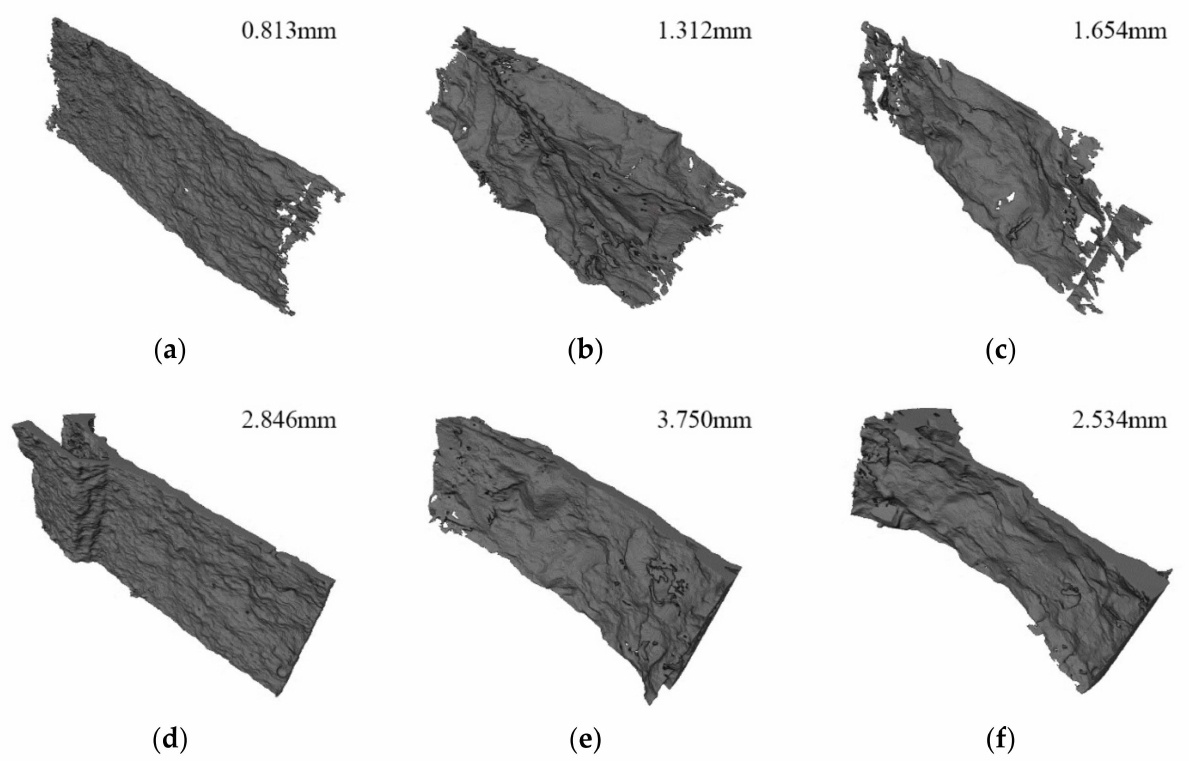
Figure 18. The 3D morphology of reconstructed cracks: ( a ) MA-02 m; ( b ) CA-02 m; ( c ) CC-02 m; ( d ) MA-2 s; ( e ) CA-2 s; ( f ) CC-2